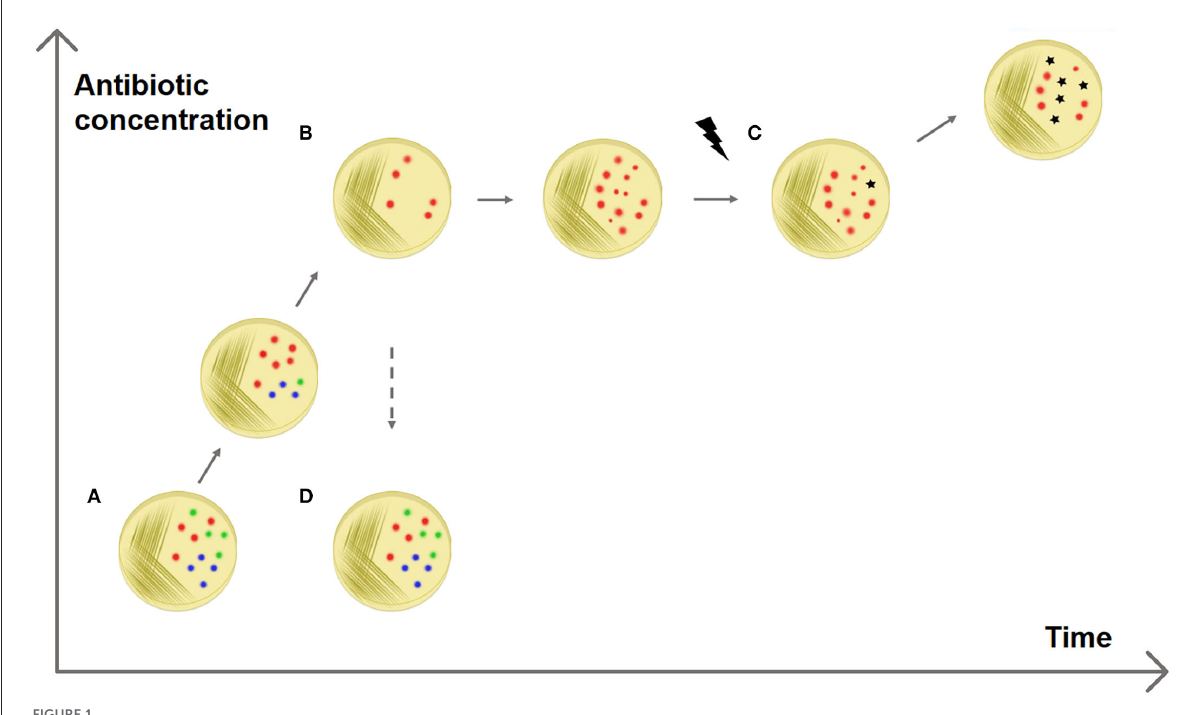
FIGURE1 Adaptive antibiotic resistance. The figure shows a possible explanation for the selection of resistances. (A) A sensitive bacterial population has a heterogeneous methylation pattern (represented by red, blue, and green dots). (B) It has been observed that when the population is exposed to increasing antibiotic concentrations some members survive better than others, without the presence of resistance genes (Motta et al., 2015). This can be explained with epigenetics: it is possible that a specific methylation pattern (red dots) increases the survival rate, e.g., enhancing the expression of efflux pump genes. (C) This fast epigenetic-based resistance mechanism allows the population to survive antibiotic exposure for enough time that resistant mutated strains can be selected. (D) AdR is a transient resistance: if the antibiotic is removed, the resistant methylation pattern is no longer advantageous and the population returns heterogeneous (and